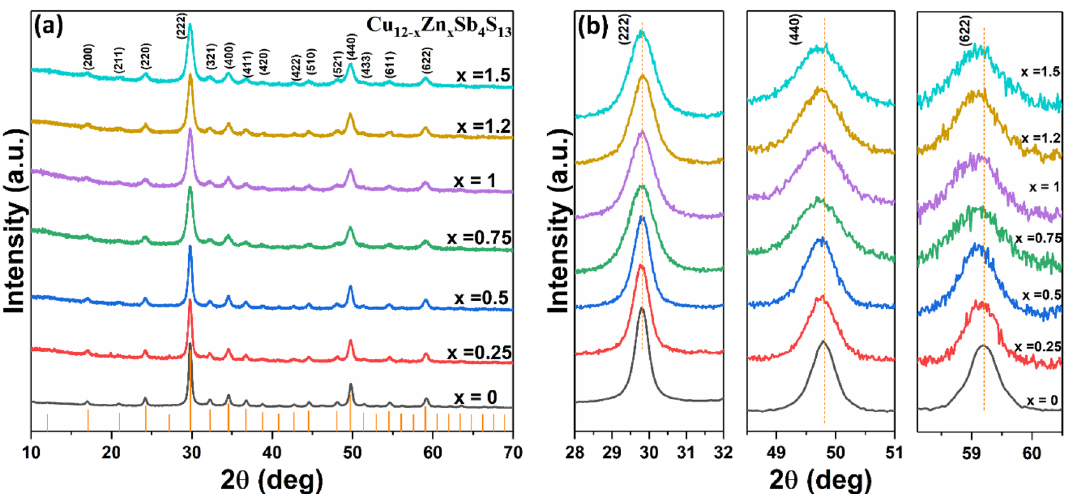
Figure 6. ( a ) p-XRD patterns of Cu 12−x Zn x Sb 4 S 13 (x = 0.25, 0.5, 0.75, 1, 1.2, 1.5) and ( b ) the three main diffraction peaks (222), (440) and (622) of Zn-doped tetrahedrite samples. Orange lines are from standard ICDD: 01-088-0283 for cubic Cu 12 Sb 4 S 13